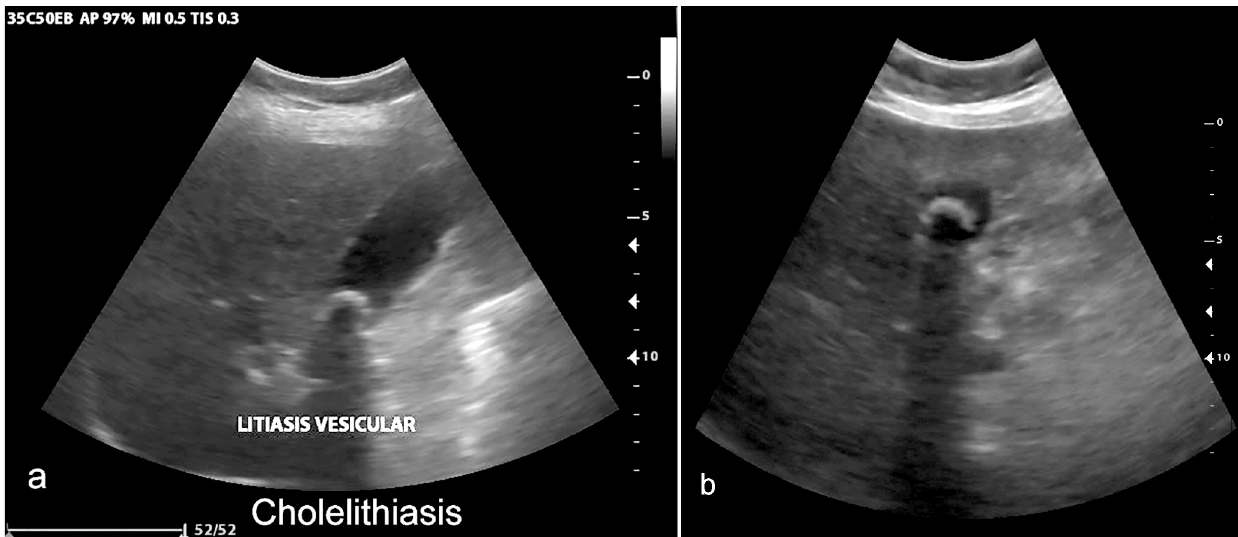
Fig 4. Cholelithiasis. Cholelithiasis with echogenic stone and posterior acoustic shadowing seen on standard of care (a) and VSI (b). Online Video 3 includes a sample cine clip of this study.